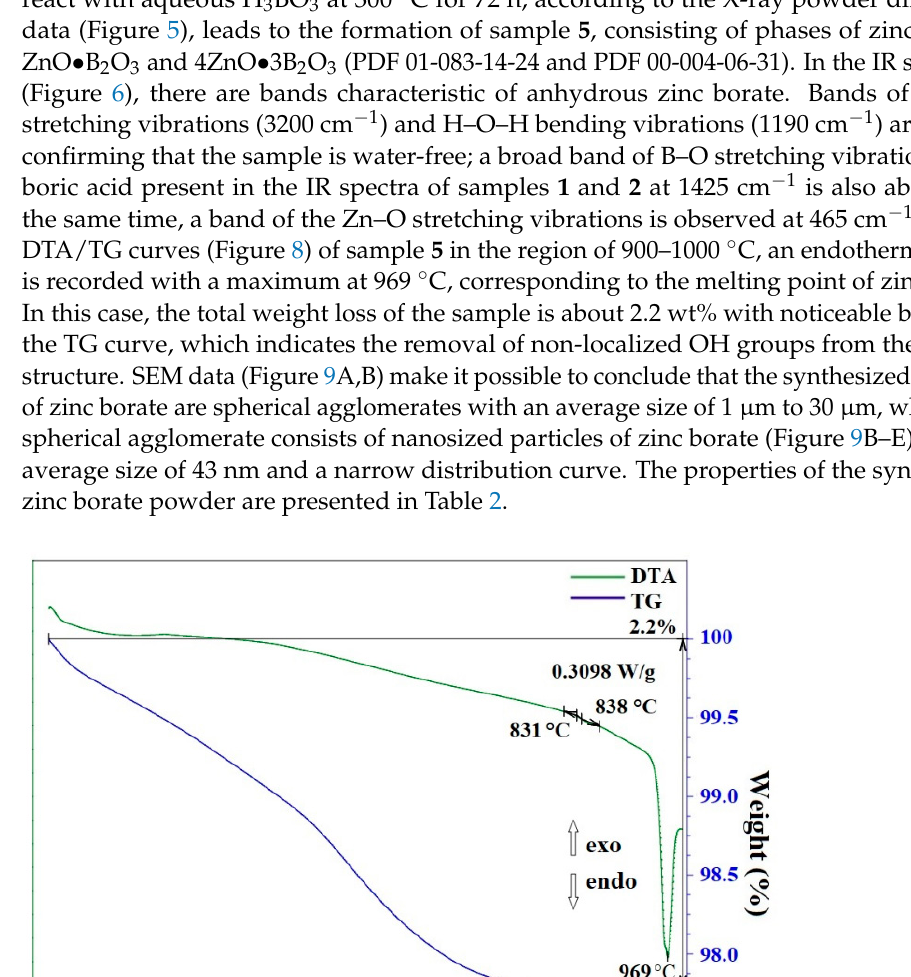
Figure 9. SEM ( A , B ) and TEM ( C – E ) images, and sample particle size distribution curve for sample 5 .